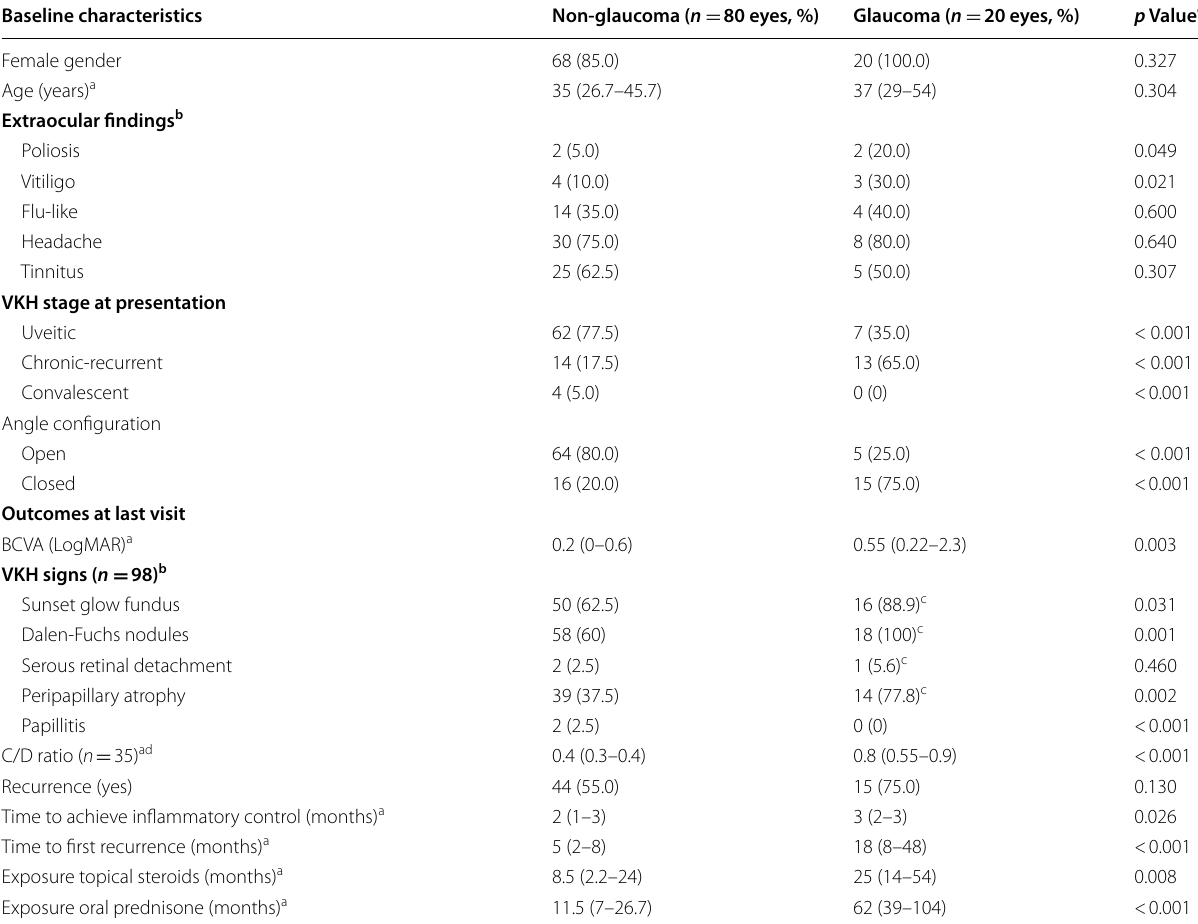
Table 2 Comparative analysis of VKH patients baseline demographic data and clinical features of VKH eyes with and without